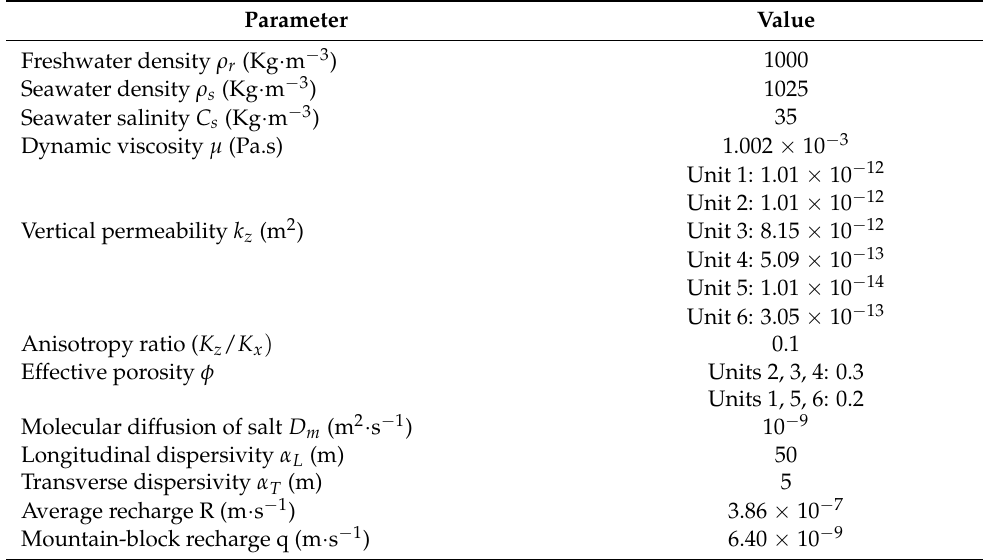
Table 2. Physical parameters used for the specific vulnerability assessments in the Akkar aquifer case study